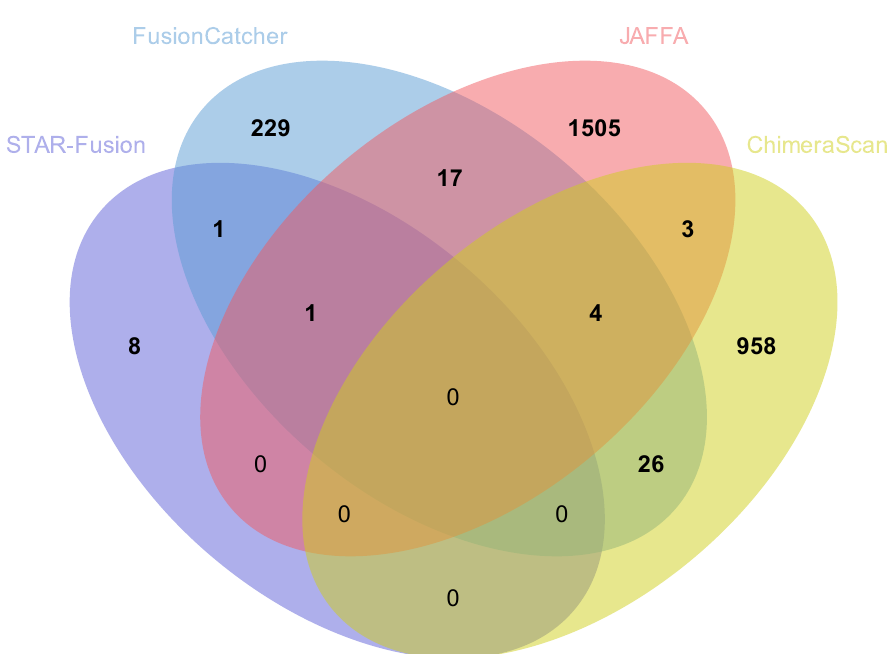
Figure 3. Comparison of fusion genes predicted by the different pipelines in European American patients. Total nonredundant fusions = 2809.